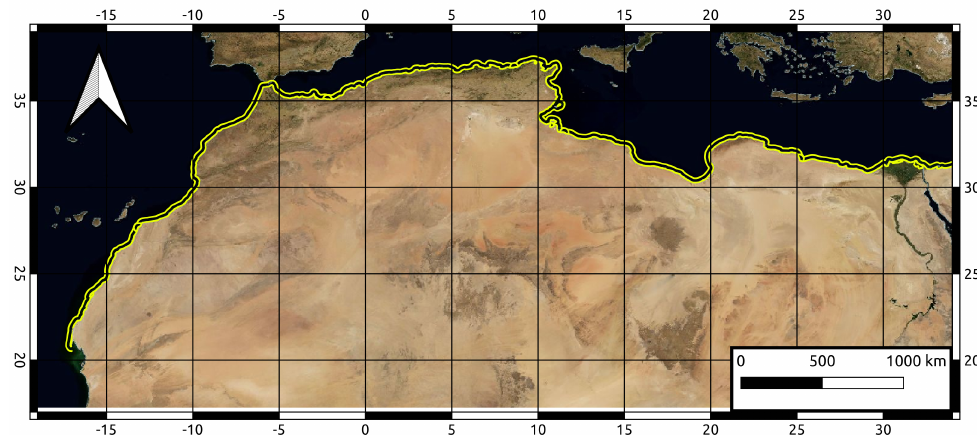
Figure 1. Contextual map of our study area: coasts of North Africa are represented by the yellow buffer. Reference coordinate system used: World Geodetic System